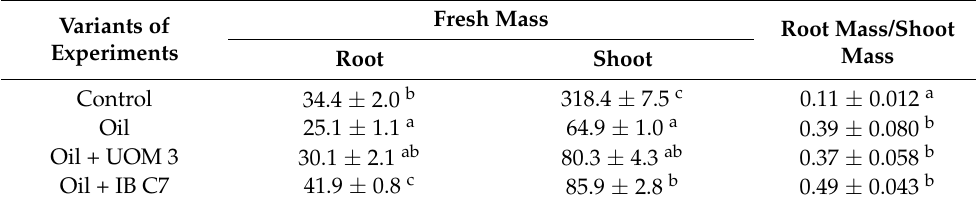
Table 1. The mass of shoots and roots of barley plants 10 days after germination, mg.